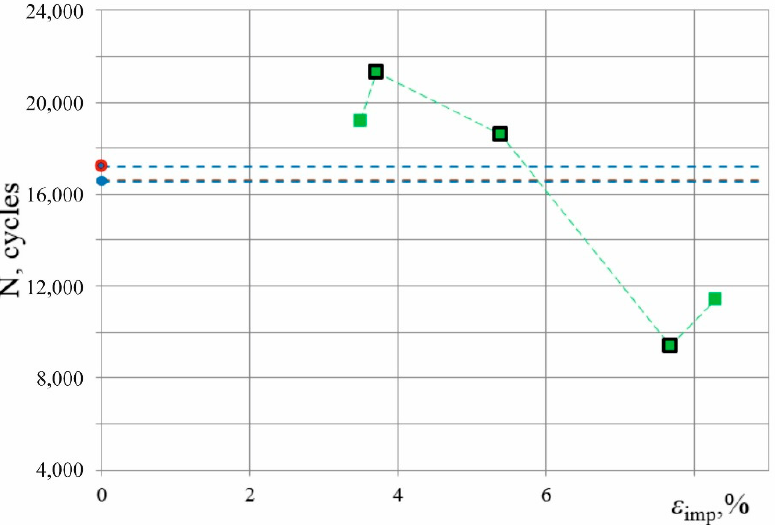
Figure 6. The effect of the intensity of the impulse energy introduction on the number of cycles to fracture of alloy D16ChATW ( σ max = 400 MPa): indicates the alloy condition after the DNP and exposure for 6–7 months; indicates the initial state of the alloy; blue lines indicate data scatter in the initial state [13].